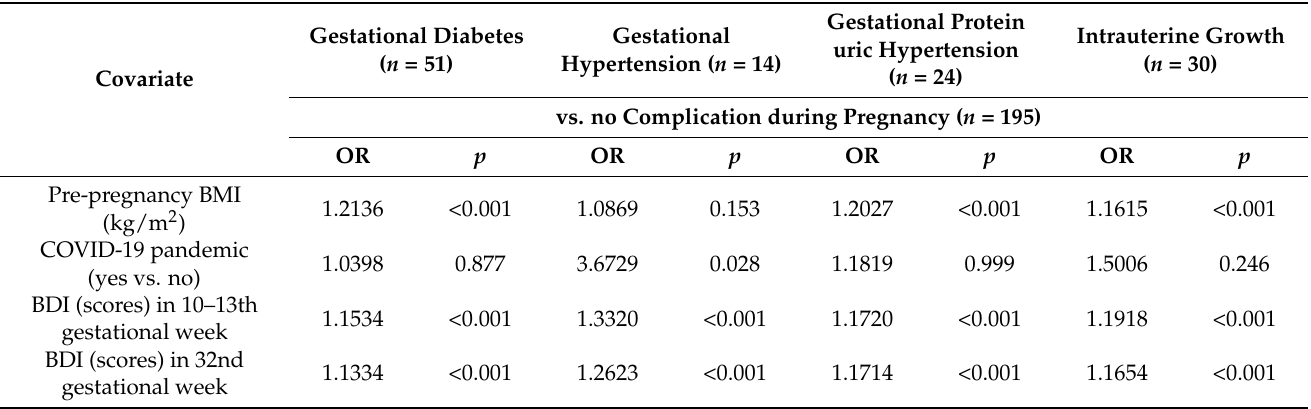
Table 5. Univariate logistic regression models of pregnancy complication against pre-pregnancy BMI, COVID-19 pandemic, and severity of depression.